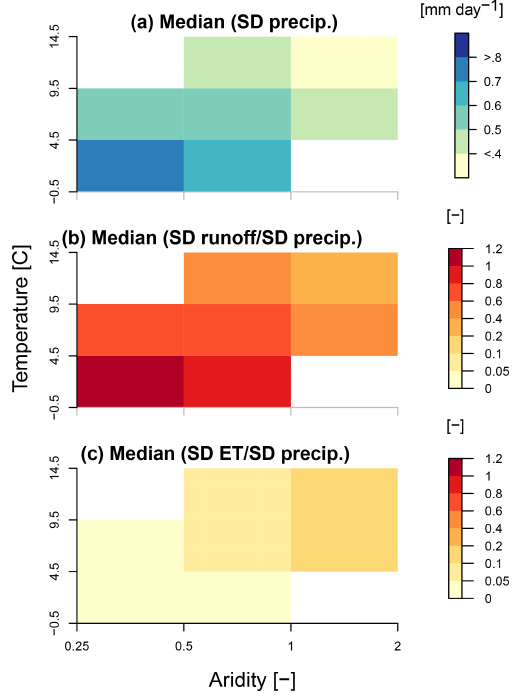
Figure 4. Climate-dependent propagation of precipitation uncer- tainty into runoff and ET. Panel (a) shows the standard deviation across precipitation products, while panels (b) and (c) show the rel- ative standard deviation of resulting runoff and ET simulations with respect to precipitation,